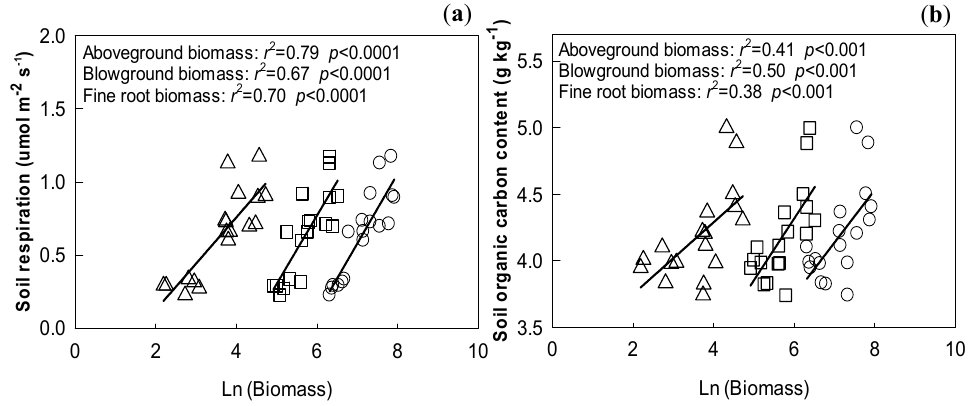
Figure 6. Relationship between soil respiration ( a ) or soil organic carbon content ( b ) and biomass. Triangle, square, and circle represented aboveground biomass, belowground biomass and fine root biomass, respectively.